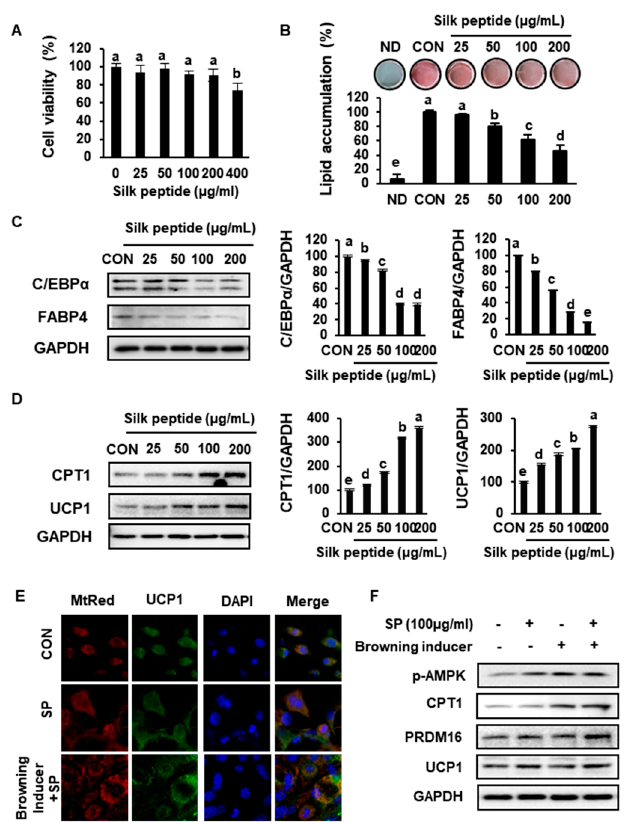
Figure 9. Silk peptide inhibits fat accumulation and increases browning in primary cultures of subcutaneous white adipocytes. ( A ) The viability of primary adipocytes treated with SP for 24 h was assessed using an MTT assay. ( B ) The e ff ect of SP on lipid accumulation was assessed using Oil red O staining. ( C , D ) The protein expression levels of C / EBP α , FABP4, CPT1, and UCP1 were measured in subcutaneous white adipocytes. ( E ) Immunofluorescence images of adipocytes were captured at 800 × magnification. After di ff erentiation, cells were fixed with methanol and then stained with MitoTracker ® 363 Deep Red or anti-UCP1 antibody. ( F ) Browning was promoted in adipocytes cultured with 50 nM T 3 and 1 mM rosiglitazone and treated with SP, and the protein expression of BAT-specific genes was measured. Data are expressed as mean ± SD ( n = 4). Values with di ff erent letters were significantly di ff erent; p < 0.05 (a > b > c > d >